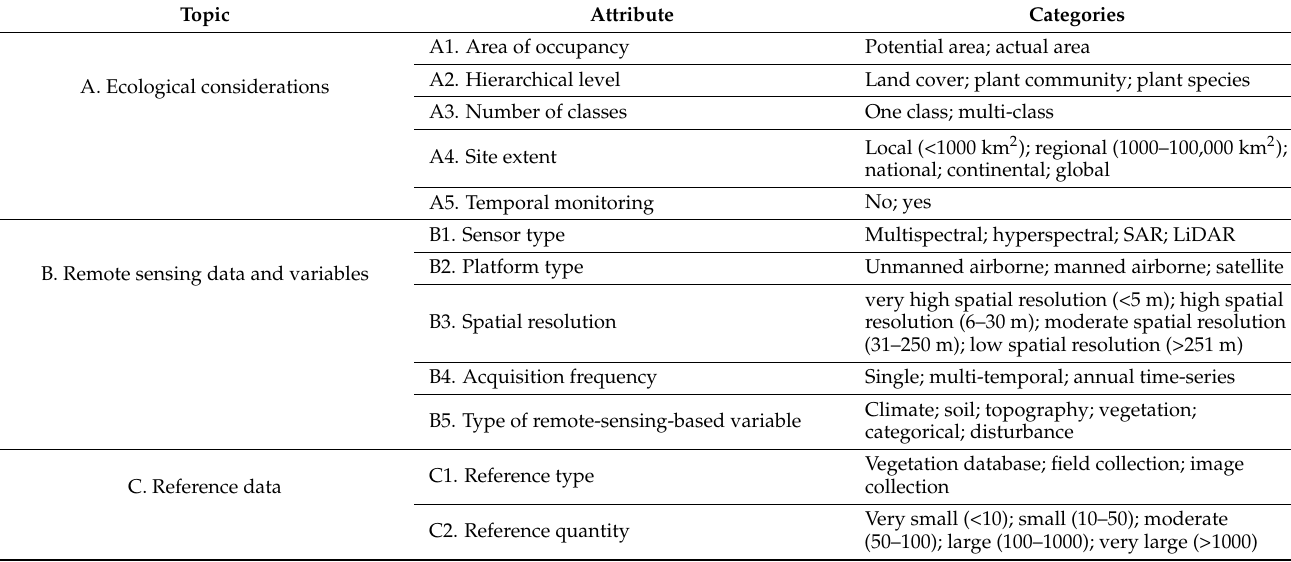
Figure 1. Flowchart used to search and review literature on remote sensing (RS) for one-class classification (OCC) of natural vegetation (time span: 2013–2020). Table 2. Topics, attributes, and categories used to analyze the articles selected (see Table S3 in Supplementary Materials for a complete description of categories).